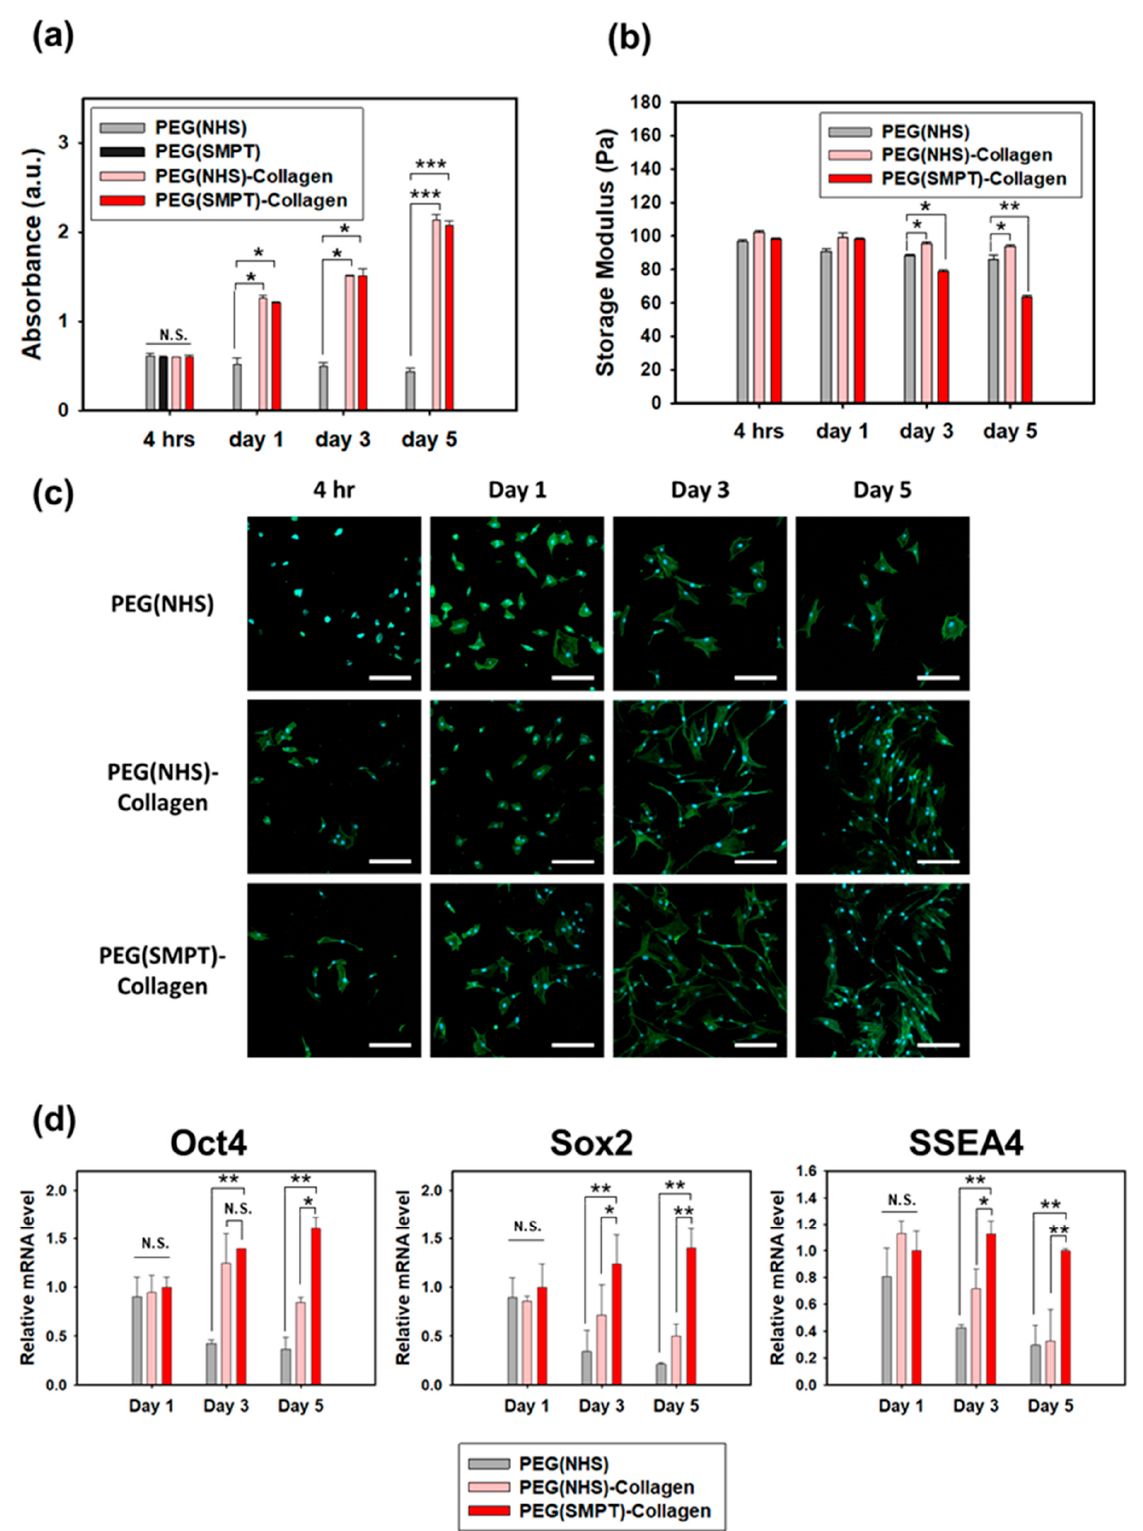
Figure 3. Characterization of ADSCs encapsulated within each hydrogel. ( a ) Proliferation of ADSCs in each hydrogel. * p < 0.05, *** p < 0.001 compared with PEG (NHS), and n.s. refers to non-signi fi cant. ( b ) Storage modulus of each hydrogel that was measured at di ff erent time points (4 h, 1, 3, and 5 days after the encapsulation). * p < 0.05, ** p < 0.01 compared with PEG (NHS). ( c ) Morphology of ADSCs encapsulated in each hydrogel observed by confocal microscopy after staining F-actin with FITC-labeled phalloidin and cell nuclei with DAPI. ( d ) The expression level of pluripotency markers (Oct4, Sox2, SSEA4) of ADSCs cultured in three di ff erent hydrogels, including PEG (NHS), PEG (NHS)-Collagen, and PEG (SMPT)-Collagen hydrogels. The gene expression levels were normalized